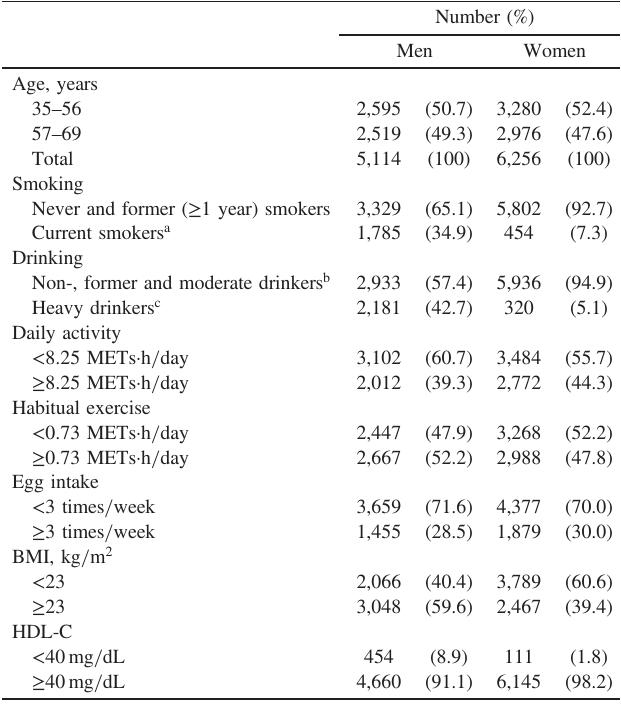
Table 1. Age-, environmental factor-, BMI-, and HDL-C level- based distribution of study subjects divided by